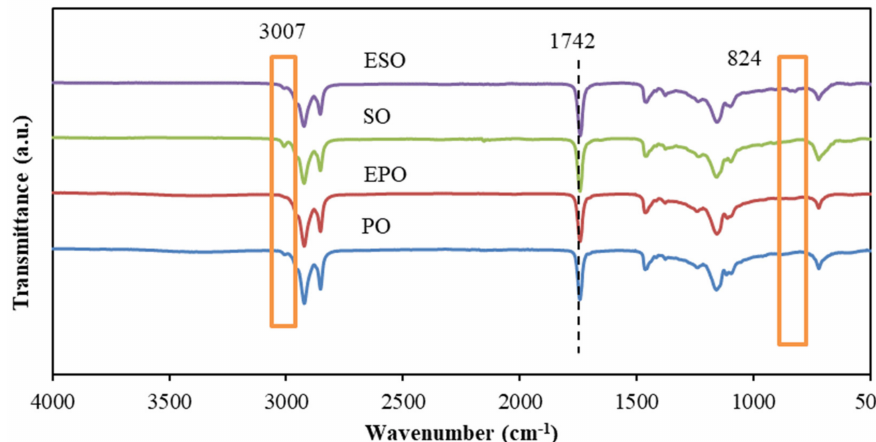
Figure 1. FTIR spectra of raw oils and epoxidized oils.